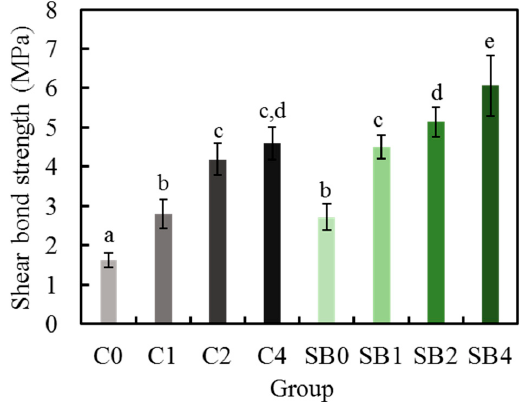
Figure 7. Shear strength of the bonding of the plasma-treated Y-TZP samples to resin. The di ff erent letters indicate significant di ff erences ( p < 0.05) ( n =